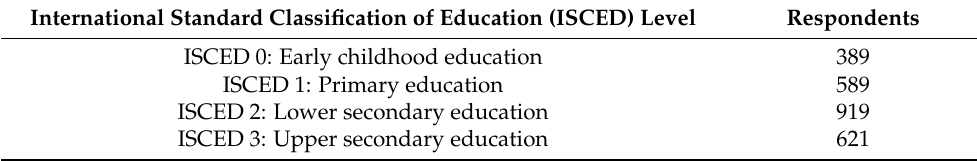
Table 3. The academic level where the respondent teachers are included (question 2). International Standard Classification of Education (ISCED)